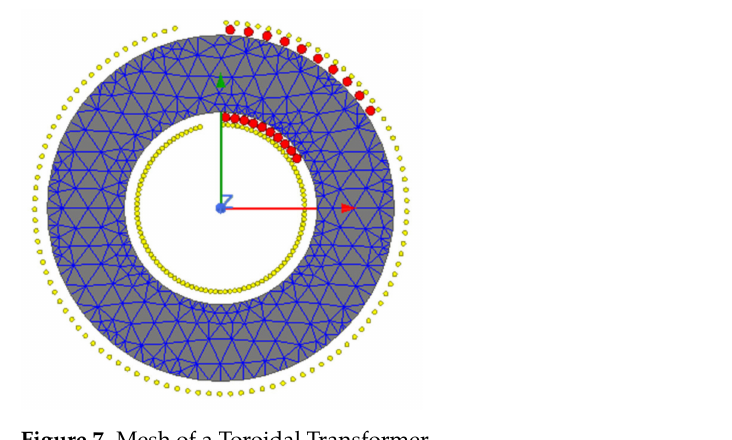
Figure 7. Mesh of a Toroidal Transformer.